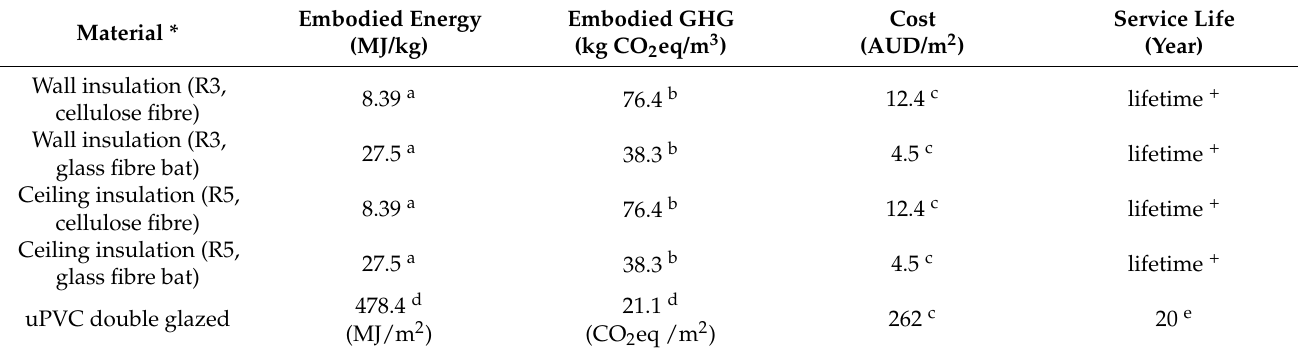
Table 7. Embodied energy, GHG and cost of the retrofit